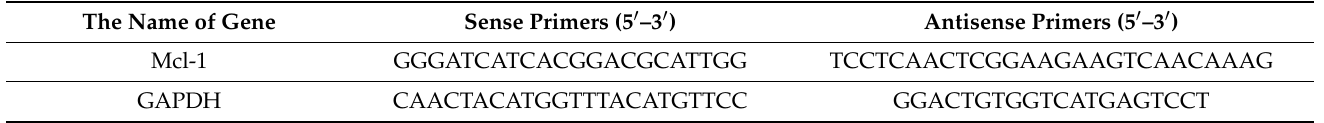
Table 3. The primers of qRT-PCR for Mcl-1 and GAPDH